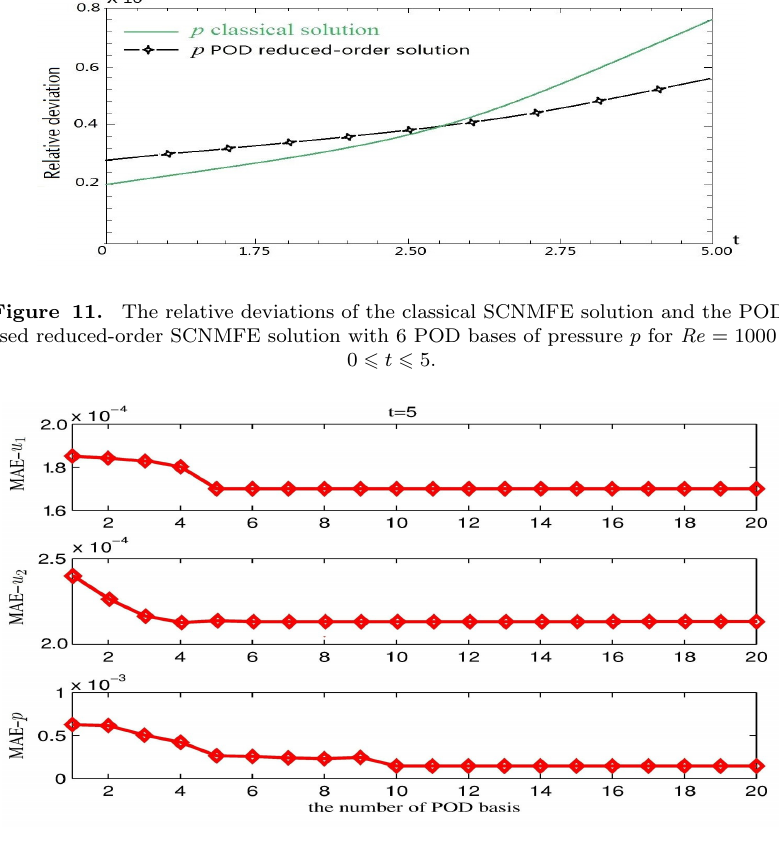
Figure 12. Absolute error for Re = 1000 and Pr = 7 when POD basic is different and at the time level t =